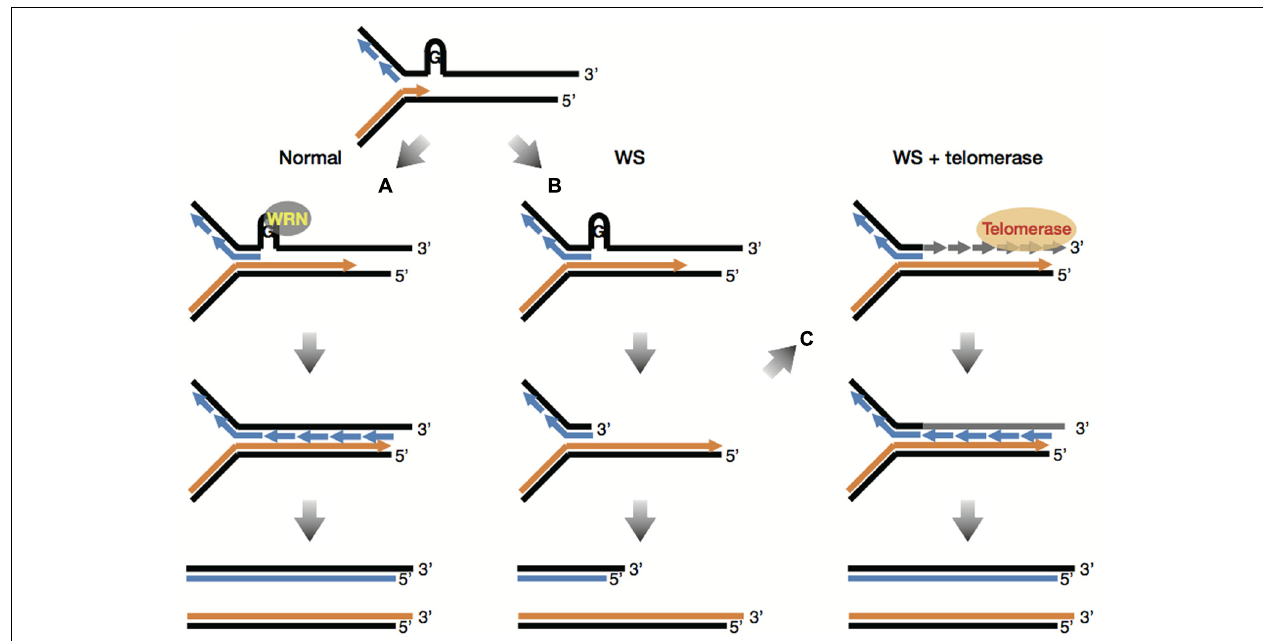
involved in DNA repair and recombination, leading to accelerated telomere shortening. (C) Telomerase can add telomeric DNA “TTAGGG” to lagging telomeres that are lost during replication in WS cells, which overcomes the lack of WRN, enabling complete replication of lagging strand G-rich telomeres. This figure is based on reference (Multani and Chang,